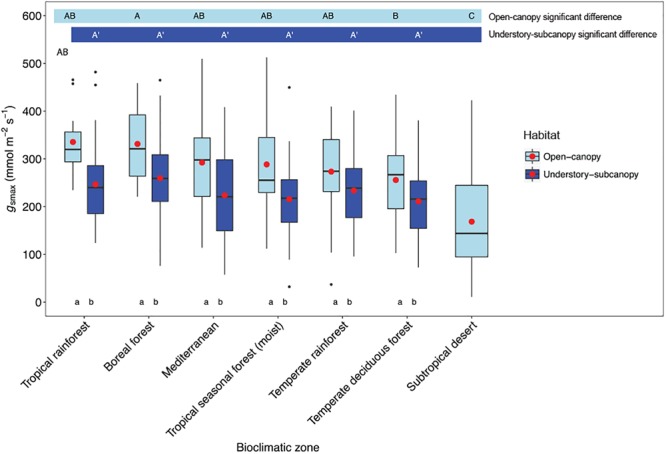
Boxplots comparing maximum stomatal conductance (gsmax) in the open-canopy and understory-subcanopy habitats across bioclimatic zones. Boxplots are arranged from highest to lowest average gsmax according to the open-canopy habitat. Capital letters above boxplots indicate pairwise comparison across bioclimatic zones using Tukey’s honest significant difference (P < 0.05) for the open-canopy (first row, without apostrophe) and the understory-subcanopy (second row, with apostrophe), (the same letter means the variables are not significantly different while a different letter means they are significantly different). ANOVA was used to analyze differences across bioclimatic zones. Boxes represent the interquartile range (IQR), horizontal line within boxes represents the median, the red dot represents the mean and whiskers extend to 1.5 times the IQR; black dots are outliers.